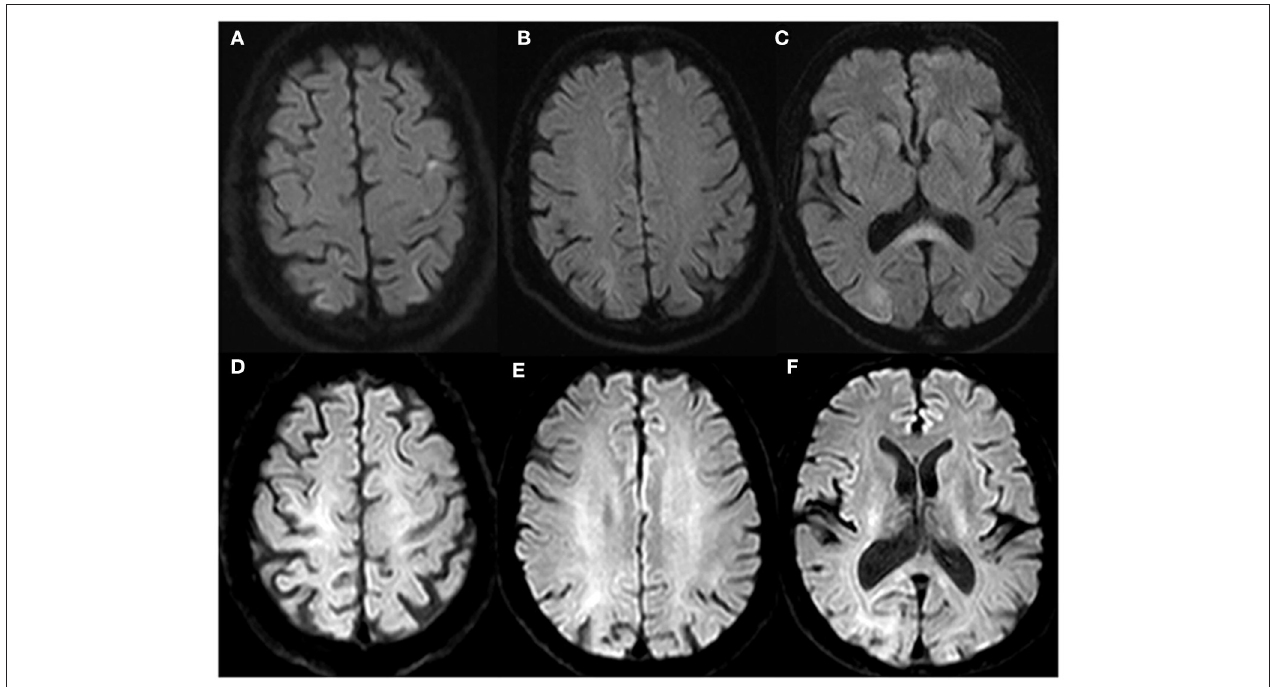
FIGURE 2 | Brain magnetic resonance imaging in follow-up. Brain MRI showed new diffusion-weighted imaging (DWI) diffusion restriction in the splenium of the corpus callosum, and diffusion restriction of the parietal and occipital lobes was lower than before on the eighth day of onset (A–C) . Brain MRI revealed the lesions in the bilateral parieto-occipital lobe and splenium of the corpus callosum disappeared, leaving slight atrophy of the bilateral occipital lobe after 4 months (D–F)